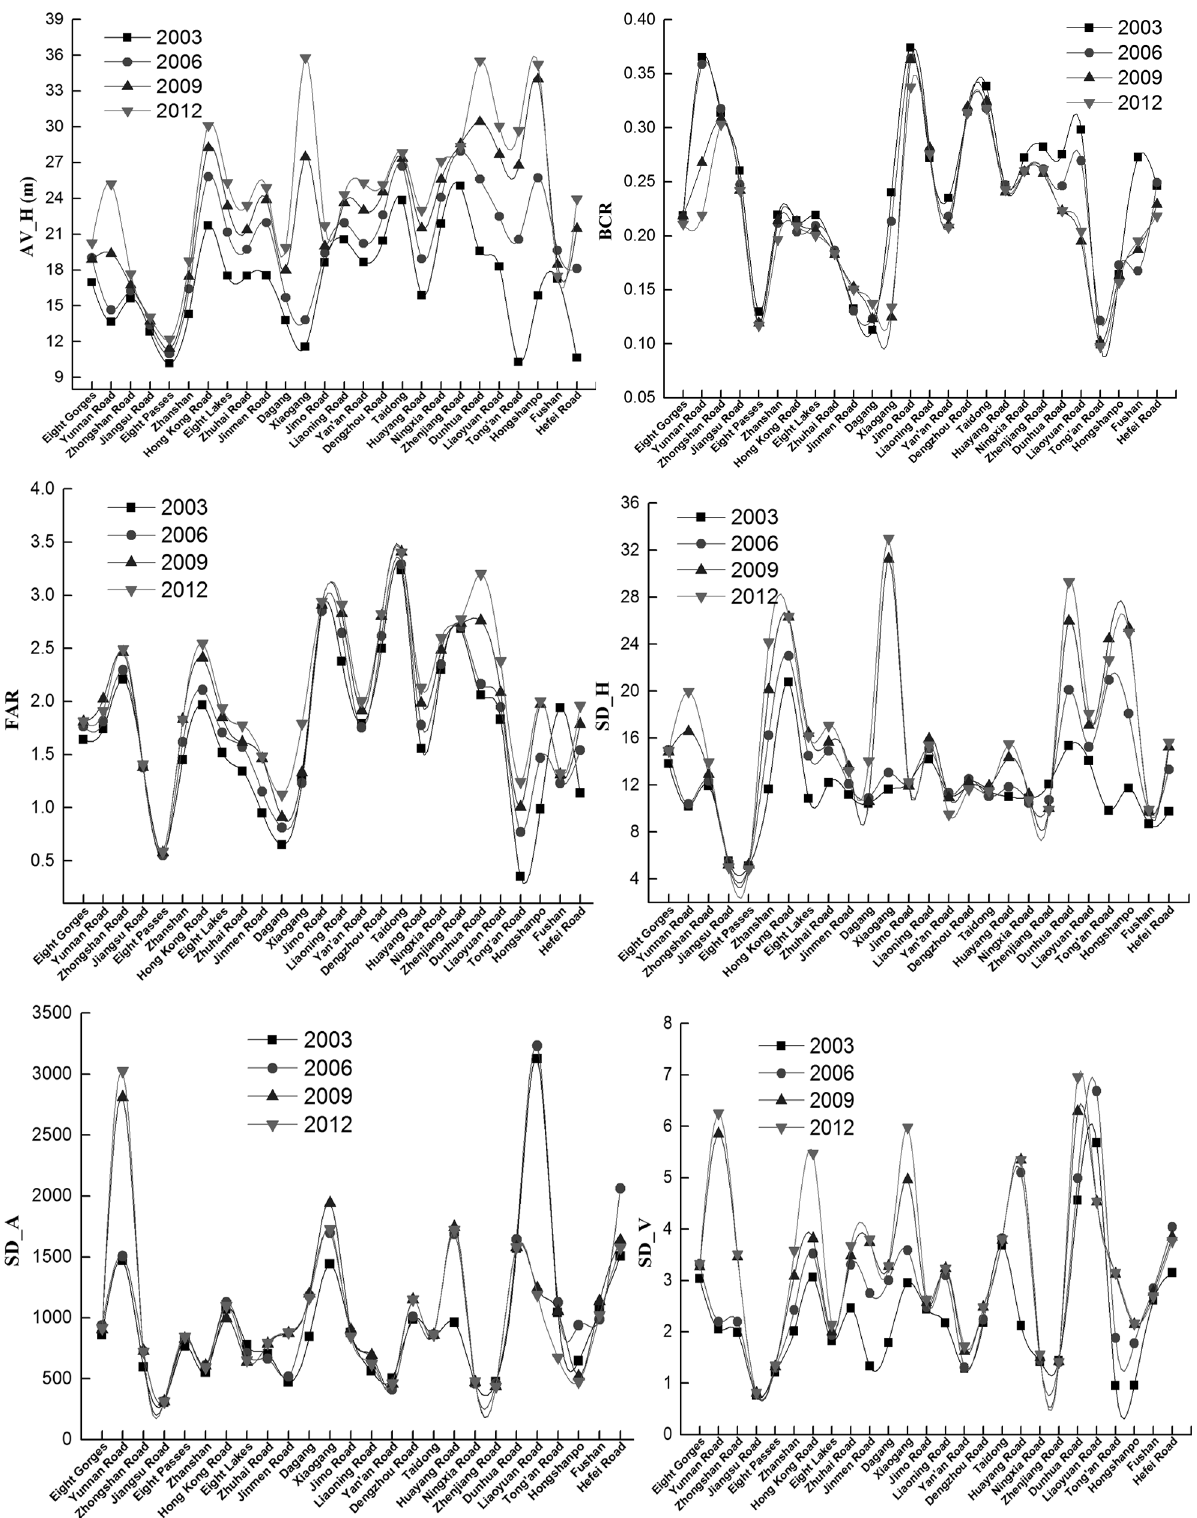
Fig 4. Variation of 3D architectural landscapes among